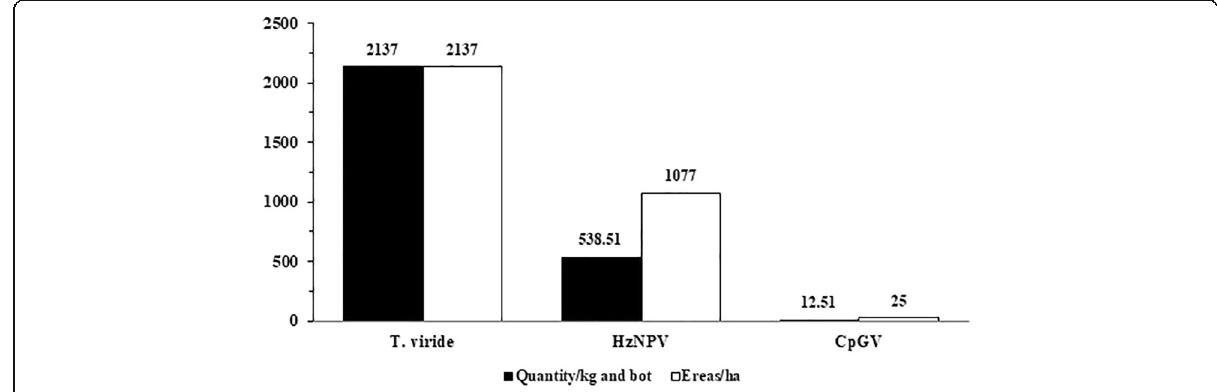
Fig. 3 Total amount of used microbial pesticides by NHLP in